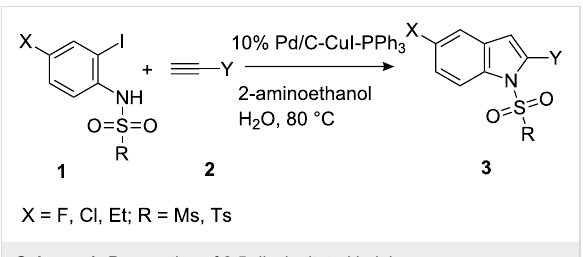
Scheme 1: Preparation of 2,5-disubstituted